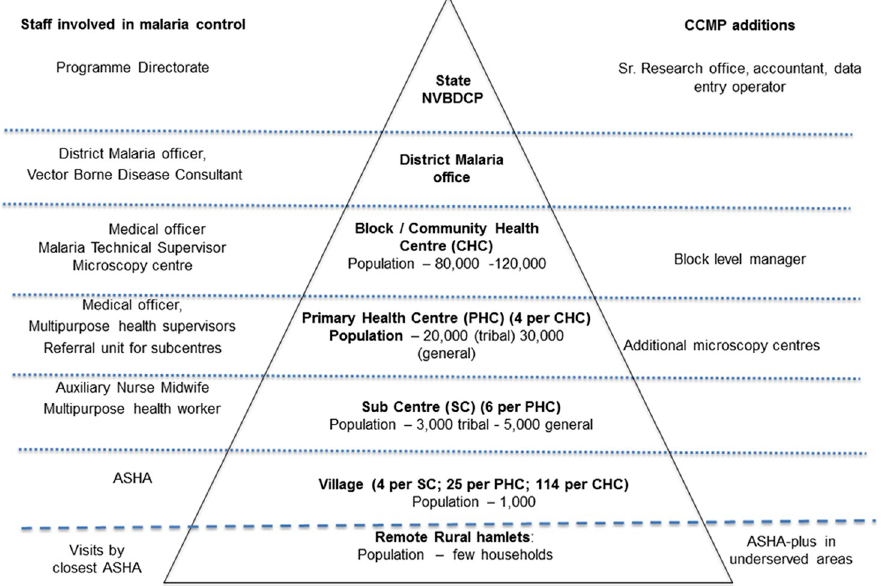
Fig 3. Health service for malaria at different levels of the